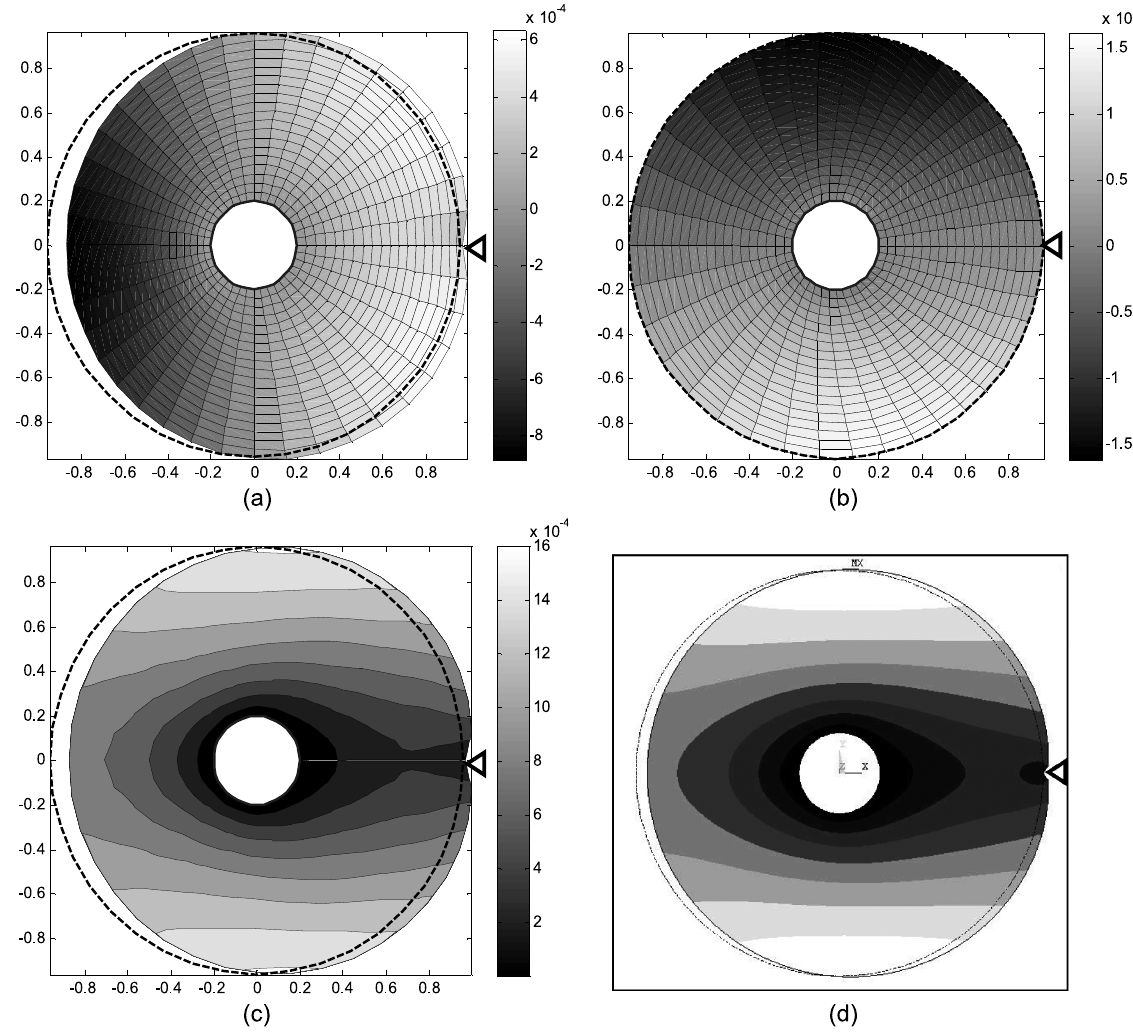
Fig. 8. Contour deformation plots for even mode (0,1) for a ’Clamped-Point Clamped’ disk: a) radial displacement; b) circumferential displacement, c) vector sum of displacements; d) deformed shape from Finite element model, : point clamped support , undeformed edge. clearly show the nodal diameter in both the radial and circumferential deformation shapes. It should be noted that both the even and odd subsystems also yield identical mode shapes, except for the shift of π /2 radians. The fi gure also shows the resultant deformation contours obtained from the vector summation of the radial and circumferential displacements and the fi nite element analysis, respectively. The addition of the outer-edge point clamped support yields a split between the odd and even frequencies, as observed in Fig. 3. The corresponding deformation modes obtained from the even and odd subsystems also differ, as seen in Figs 8 and 9 for mode (0,1), respectively. Each fi gure illustrates predominantly radial and circumferential deformation shapes together with the resultant deformation contours. The resultant displacement contours are quite similar to those obtained from the fi nite element analysis in both the cases. A comparison of Figs 7 and 8 suggests that the addition of the point clamped support does not affect the predominantly circumferential mode of the even subsystem. In a similar manner, the predominantly radial mode of the odd subsystem is insensitive to the point clamped support. This can also be deduced from Eqs (3), (4) and 2.2, which show that the even subsystem is affected only by the radial stiffness constant of the point spring at θ = 0, while the odd subsystem is in fl uenced only by the circumferential stiffness of the point spring. The 0